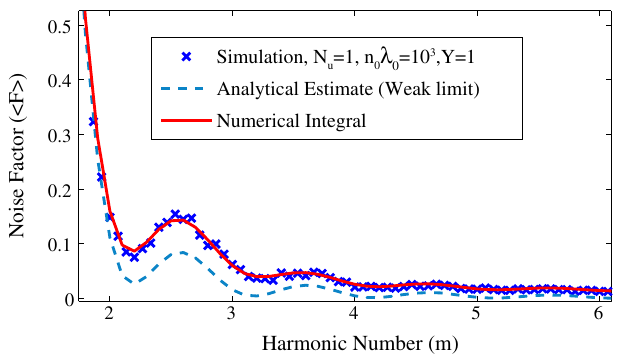
FIG. 8. A close-up of Fig. 7 shows agreement with the ana- lytical expression starts to fail for m * 2 , but the numerical integral matches well everywhere.